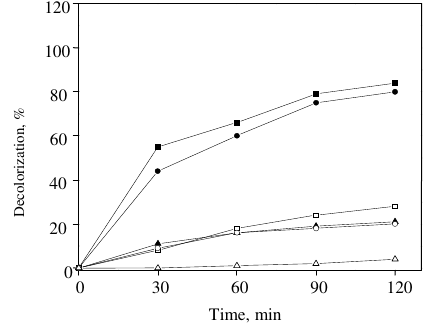
Figure 4. Effect of concentration of Reactive Red 120 on the efficiency of decolourization in Sun light.( ■ ) TiO /UV 2 / 5 mg/L, ( ● )TiO /SL 10 mg/L, ( ▲ )TiO 2 2 50 mg/L, ( □ ) SL 5 mg/L, ( ○ ) SL 10